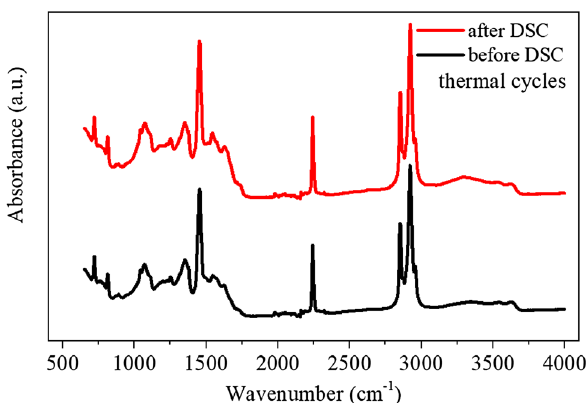
Figure 9. FTIR of composite PAN-50PCM32 nanofiber mat before and after 50 consecutive DSC thermal cycles.